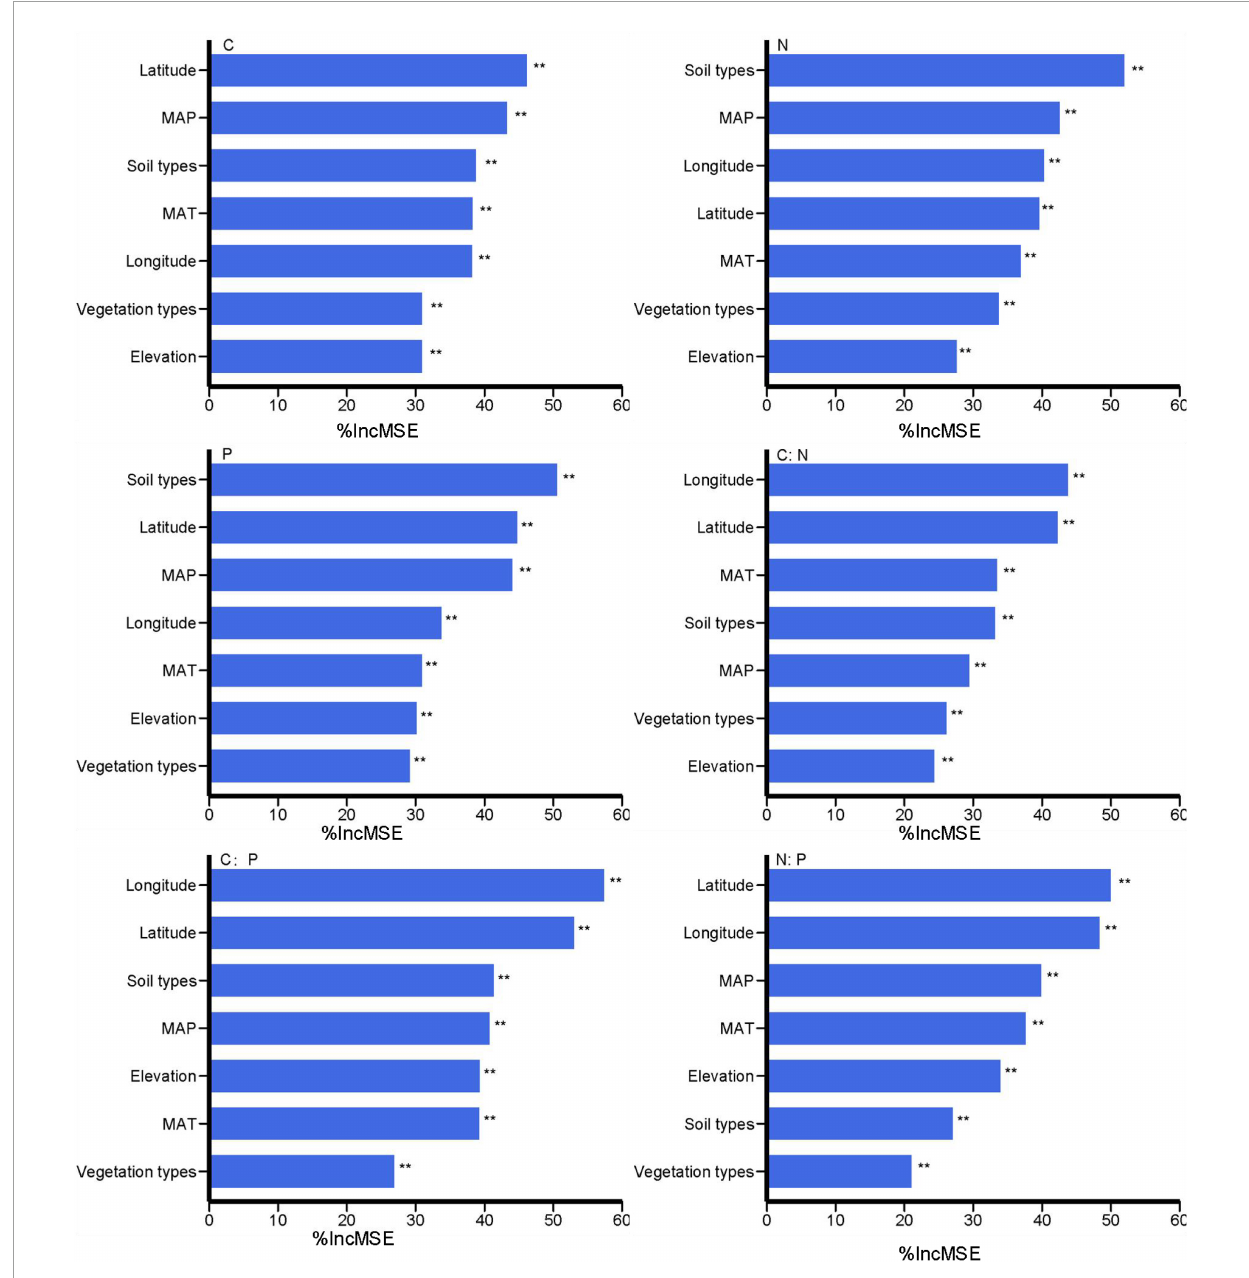
FIGURE7 Importance (the relative increase in mean square error, %IncMSE) of variables contributing to soil C, N, P concentrations and their ratios in Guangxi forests.